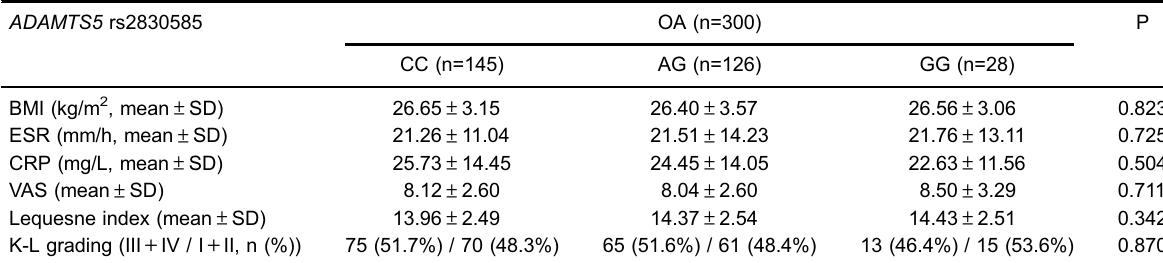
Table 6. Comparison of studied data according to ADAMTS5 genotypes in all osteoarthritis (OA) cases. ADAMTS5 rs2830585